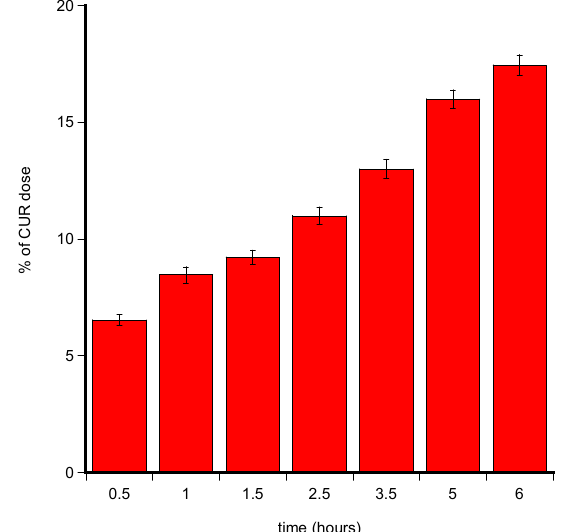
Figure 13. Percent of CUR dose recovery from the porcine membrane at different time points. Values are presented as means ± SE ( n = 3).